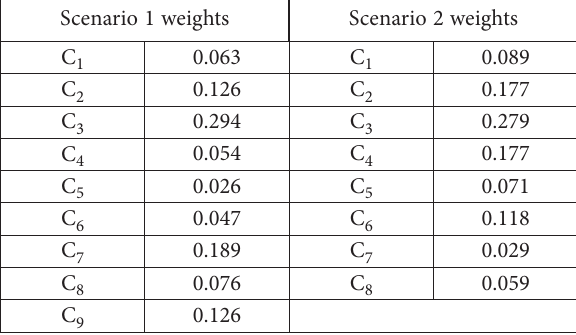
Table 6. The final results and weights